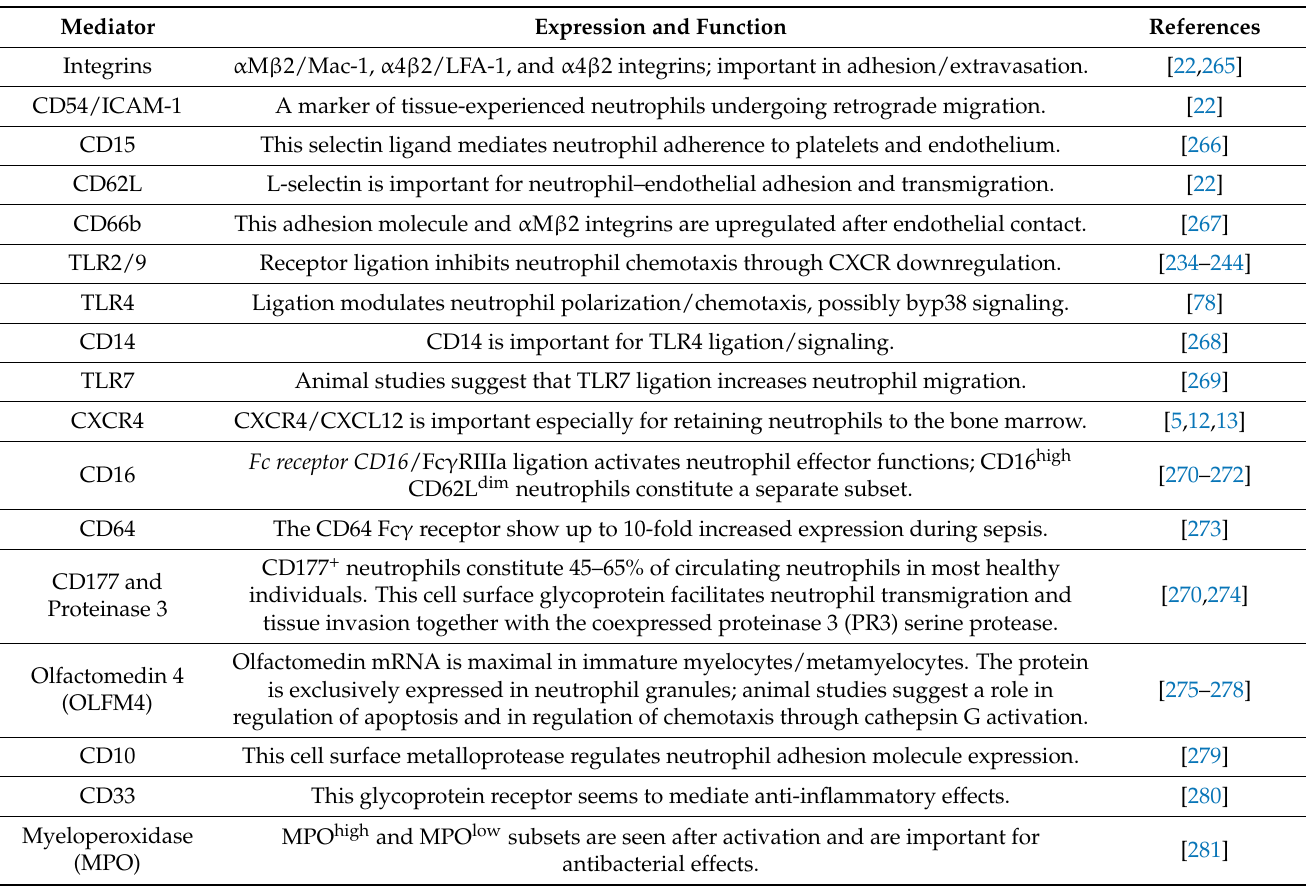
Table 3. Individual molecular markers used to characterize neutrophil subsets and their involvement in neutrophil